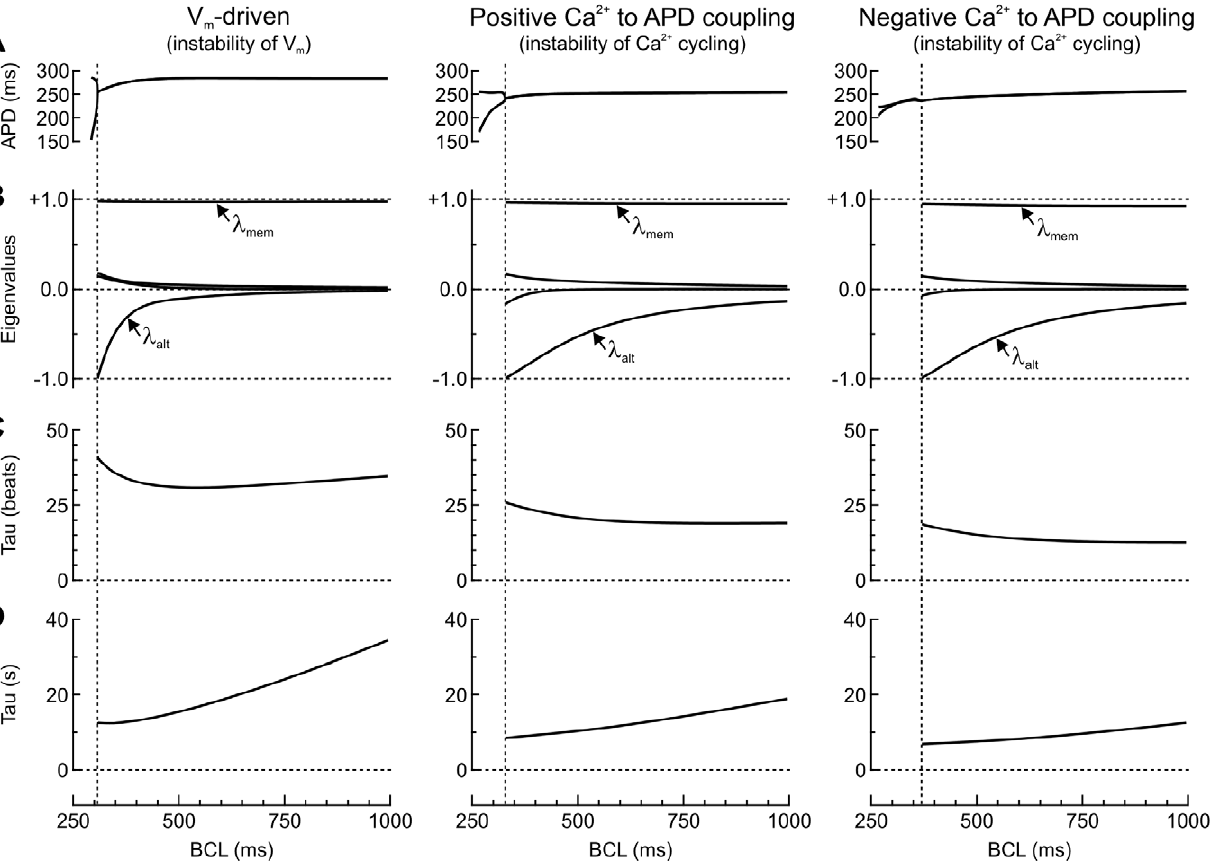
Figure 1. Bifurcation to alternans and eigenvalues in the three model versions. A : APD vs. BCL at steady state pacing (relative beat to beat variation of model variables , 10 2 7 ). The vertical dotted lines denote the bifurcations to alternans. B : Eigenvalues with an absolute value . 0.1 vs. BCL. The eigenvalue closest to 2 1 is the alternans eigenvalue l alt . The eigenvalue closest to + 1 is the principal memory eigenvalue l mem . C : Time constant of memory (expressed in number of beats, Eq. 23). D : The same time constant expressed in units of time (Eq. 24).